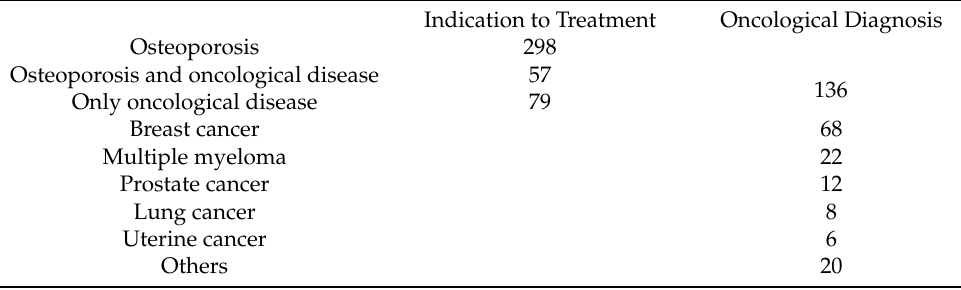
Table 2. Indication for treatment with ARDs, main oncological diagnoses are listed. Indication to Treatment Oncological Diagnosis Osteoporosis 298 Osteoporosis and oncological disease 57 136 Only oncological disease 79 Breast cancer 68 Multiple myeloma 22 Prostate cancer 12 Lung cancer Uterine cancer Others